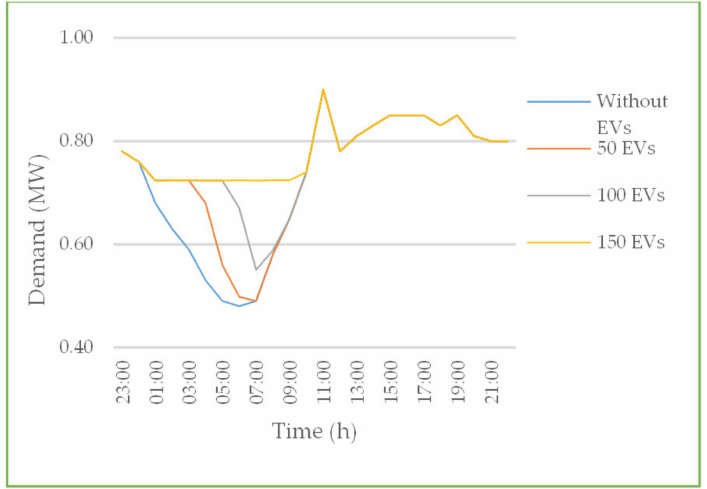
Figure 4. The effect of charging on load curve 2 (LC2) when N = 50, 100 and 150 cars are used for valley filling anytime during the